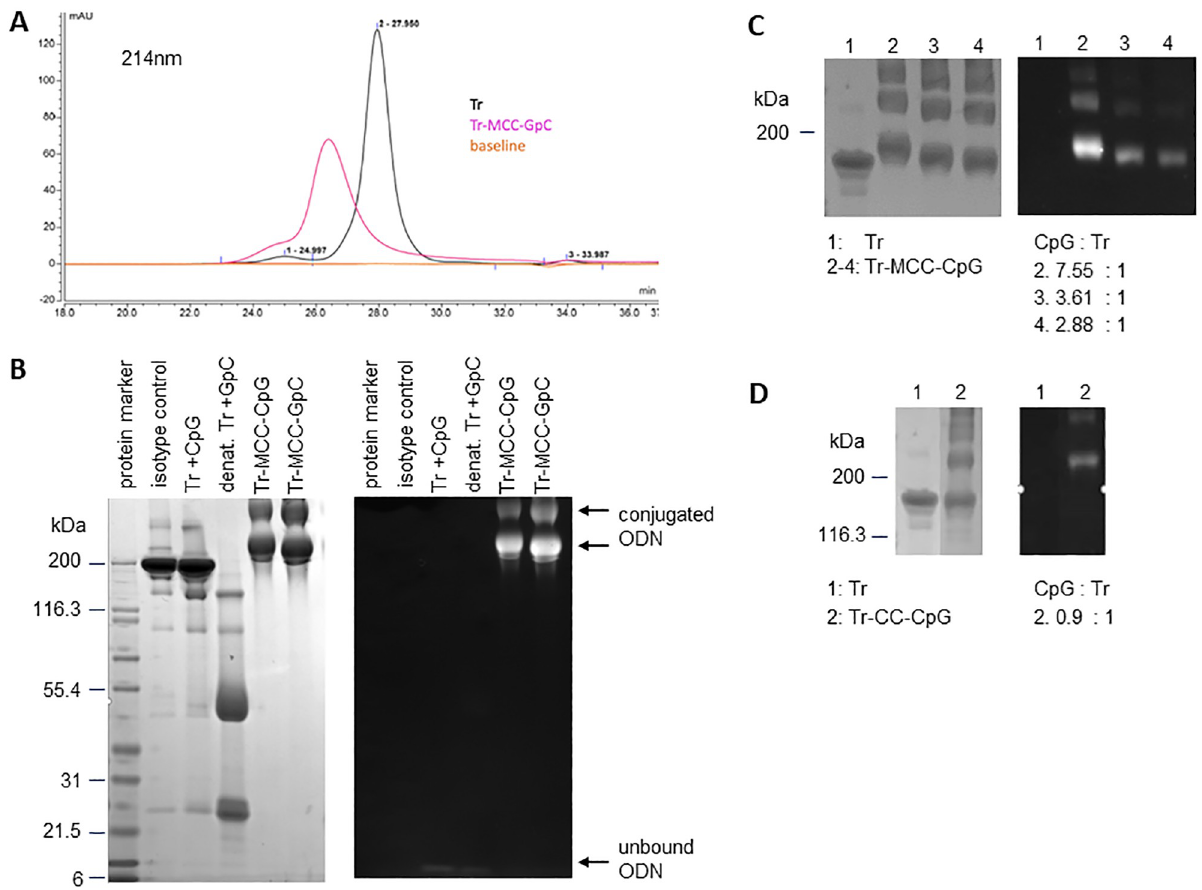
Fig 1. Characterization of antibody-ODN conjugates by SEC-HPLC and SDS-PAGE. (A) HPLC analysis of Trastuzumab (Tr) and Trastuzumab- MCC-GpC (Tr-MCC-GpC) conjugate eluted on a TSK G4000SWXL column. The ODN to antibody ratio of the purified conjugate was 6.28. Overlaid chromatograms from one representative analysis are shown. (B) SDS-PAGE analysis of Trastuzumab with unconjugated CpG (Tr +CpG) and Trastuzumab-MCC-ODN. The Tr-MCC-GpC conjugates corresponds to the sample shown in A. The Tr-MCC-CpG conjugate had a ODN: antibody ratio of 9.8. Denatured Tr plus unconjugated ODN was analysed as control as was an IgG1 isotype control Ab. The gel was stained sequentially with Ethidium Bromide (right panel) for visualisation of ODN content and SimplyBlue (left panel) for analysis of protein content. (C) SDS-PAGE analysis of Trastuzumab (Tr) and Tr-MCC-CpG conjugate under non-reducing conditions. Tr-MCC-CpG conjugate (2–4) was generated in PBS buffer with a molar excess of 34 SMCC and 10, 6 and 3 ODN, respectively. The resulting conjugates had a ODN: antibody ratio of 7.55, 3.61 and 2.88:1, respectively. The data are representative of five independent experiments. (D) SDS-PAGE analysis of Tr and Tr-CC-CpG conjugate under non-reducing conditions. The conjugate had an ODN: antibody ratio of 0.9:1 and the analysis is from a single experiment.